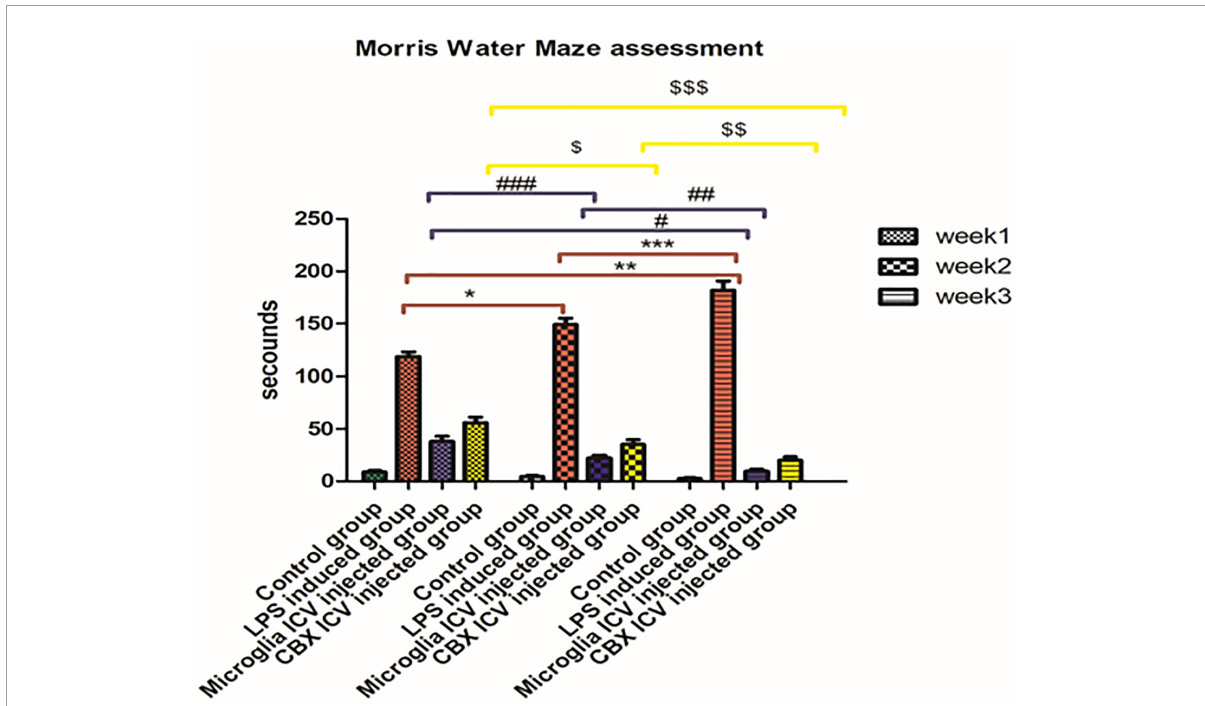
FIGURE3 Latency time in seconds taken by each rat to reach the platform in the Morris Water Maze (MWM). Represented data were expressed as mean ± SD ( n = 6 per group) (ANOVA, repeated measurement, Bonferroni post-hoc test, p < 0.05). The same asterisks represent an insignificant difference p >